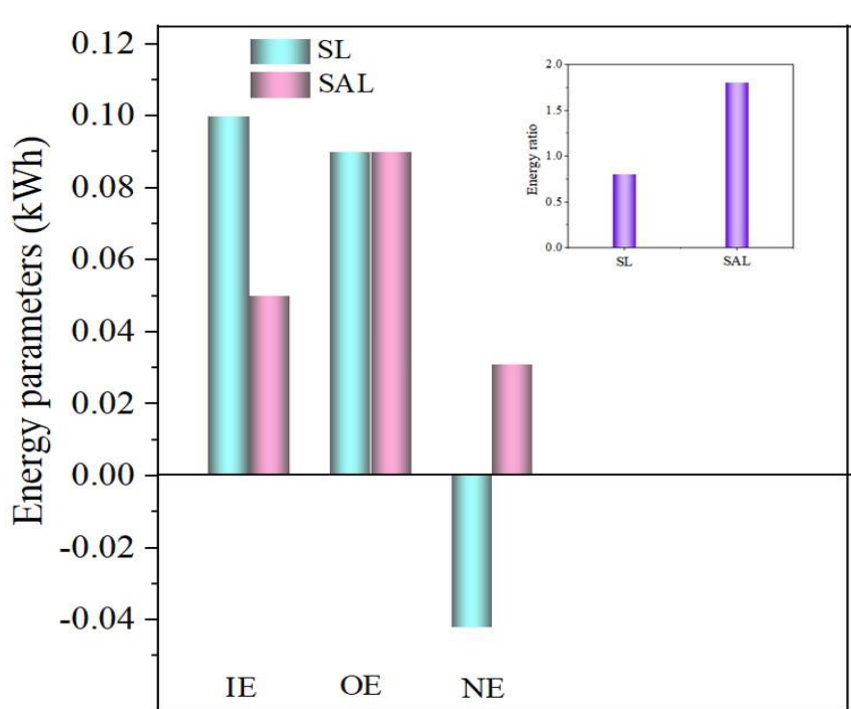
Figure 6. Energy evaluation in SL and SAL.